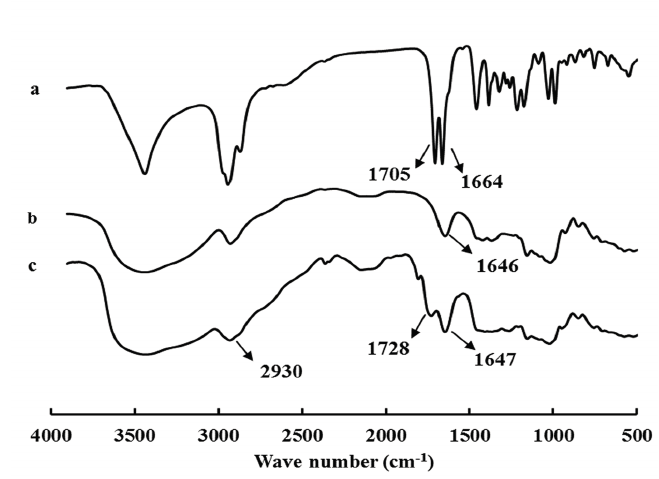
Figure 1. Fourier transform-infrared (FT-IR) spectra for ( a ) GA, ( b ) pullulan, and ( c )